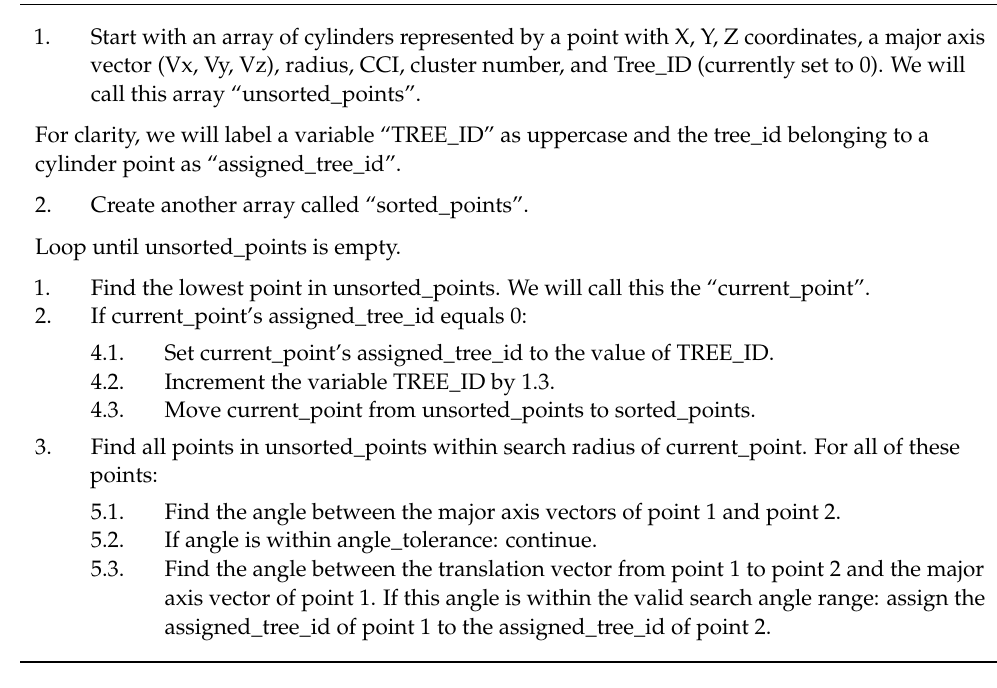
Algorithm 1. Cylinder Sorting Algorithm Part 1.